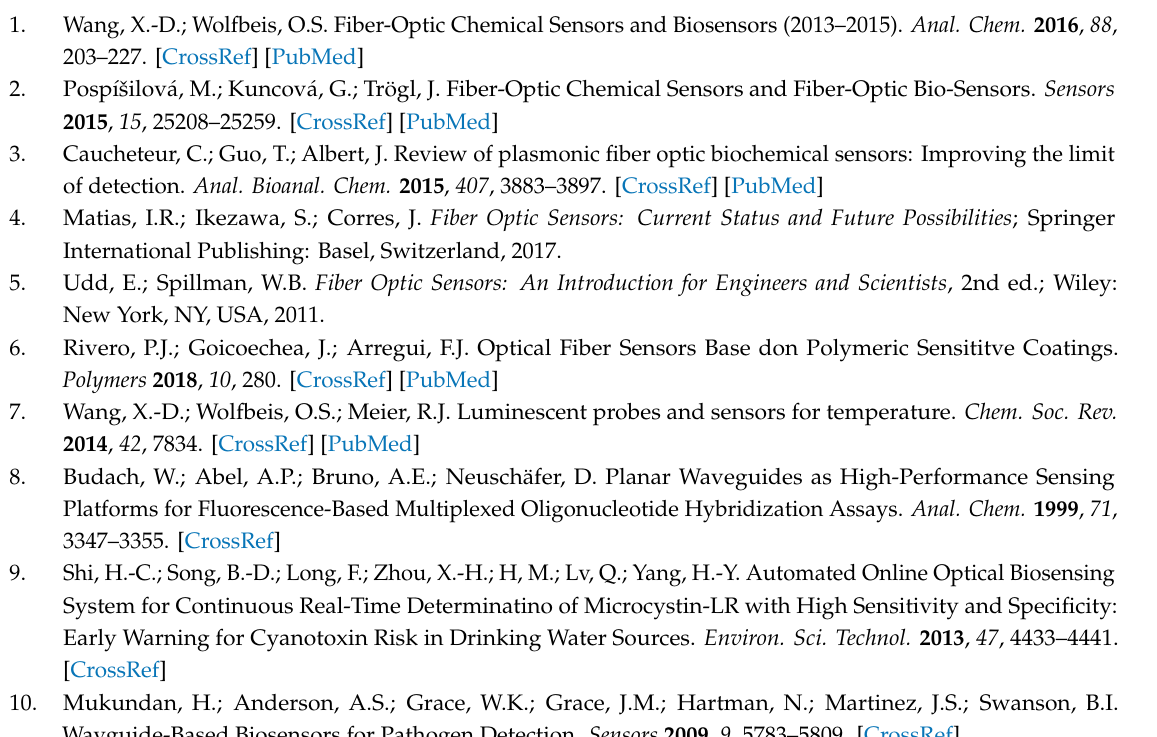
s1. Figure S1: TGA analysis and derivative of the TGA curve for the photocured LCP, Figure S2: Photoluminescence emission spectrum of a deposited film of HRI-F27-02 cured under mild vacuum conditions. Photoluminescence emission spectrum is taken with excitation at 390 nm, Figure S3: Photoluminescence emission spectrum of a deposited film of HRI-RhodB-02 cured under mild vacuum conditions. Photoluminescence emission spectrum is taken with excitation at 530 nm, Figure S4: Optical planar waveguide sensor including a luminescent coupling element and a luminescent temperature readout element (a) in the non-transmissive state, at low temperature, and (b) in the transmissive state, at high temperature. Light from a blue LED (peak wavelength at 455 nm), excites the photocured HRI-F27-02 layer that emits light, partly coupled in the planar waveguide and travelling towards the thermoresponsive liquid crystal polymer sensor material. Waveguided light reaching the HRI-RhodB-02 layer is partly absorbed and re-emited as orange-red light. A photodetector measures the red light (632 nm) intensity emitted by this emissive layer as a function of the LCP layer